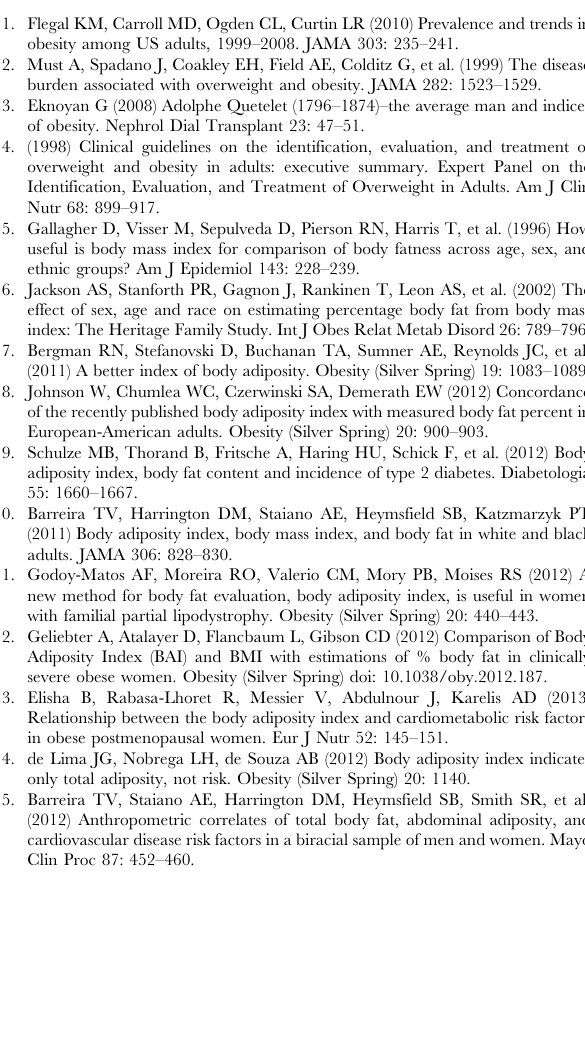
Table S1 Correlations of anthropometric measure- ments with cardiometabolic risk factors taking family relationships into consideration Table S2 Comparison of correlation coefficients be- tween cardiometabolic risk factors and hip circumfer- ence versus